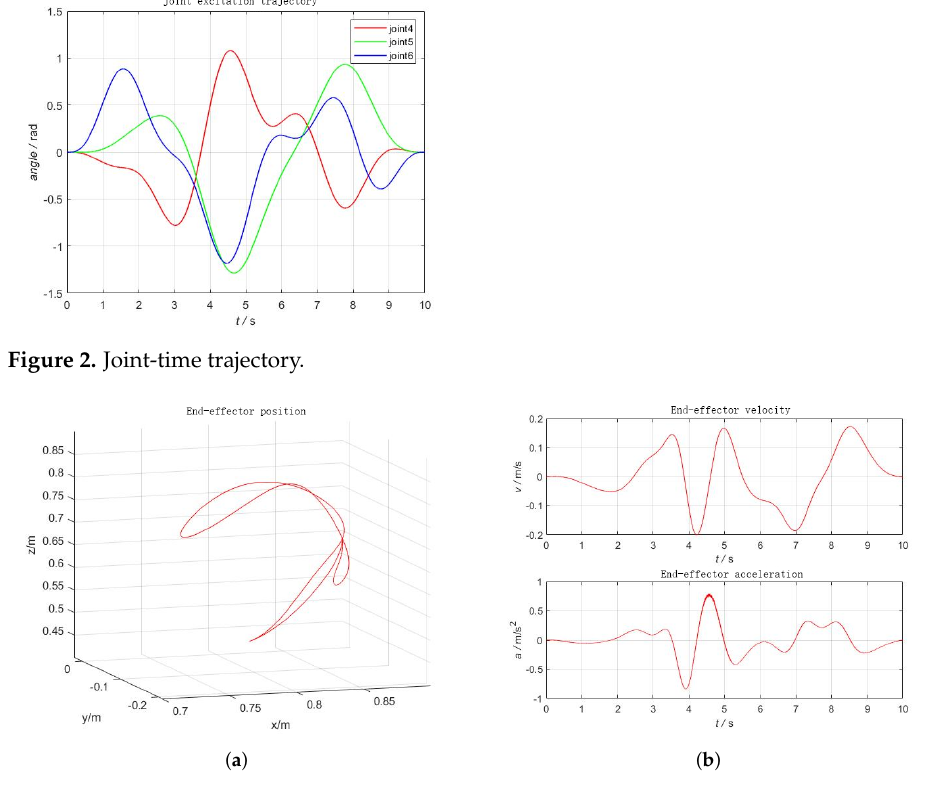
Figure 3. End-effector position, velocity, and acceleration profiles. ( a ) Position; ( b ) Velocity,